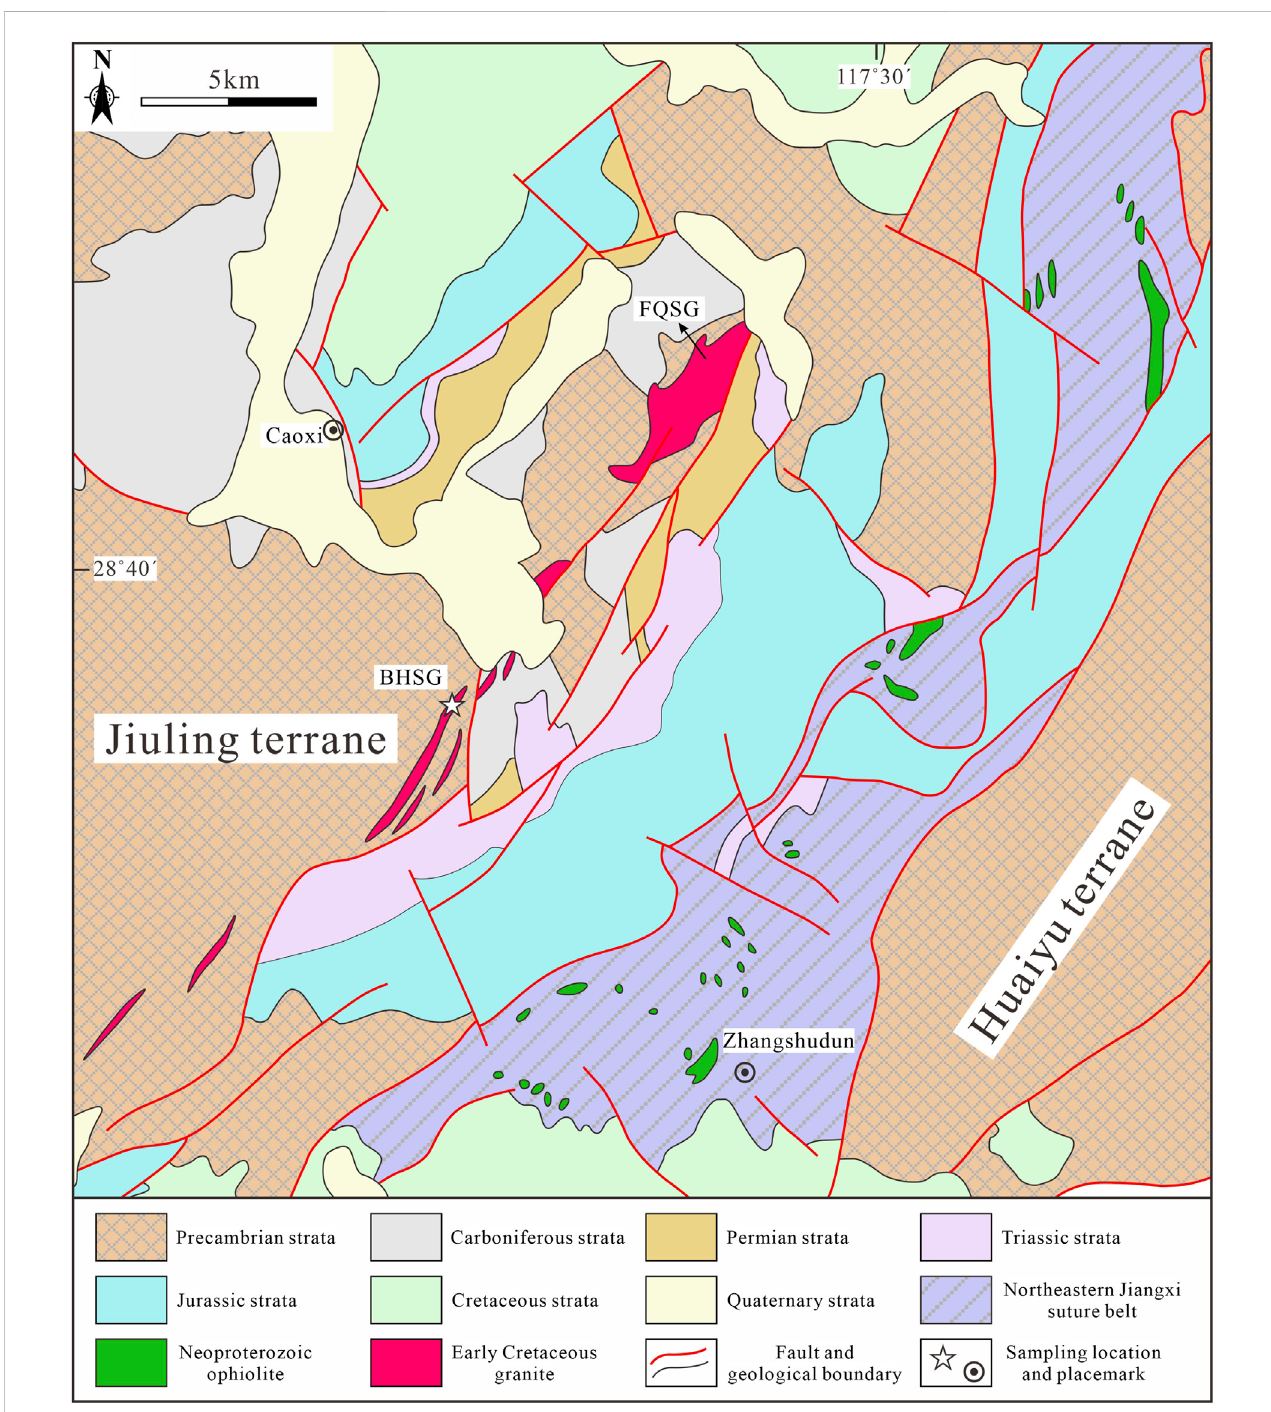
FIGURE 2 Geological map of the Fuquanshan area (modi fi ed from Northeastern Jiangxi Geological Party, Bureau of Geology and Mineral Resources of Jiangxi Province).